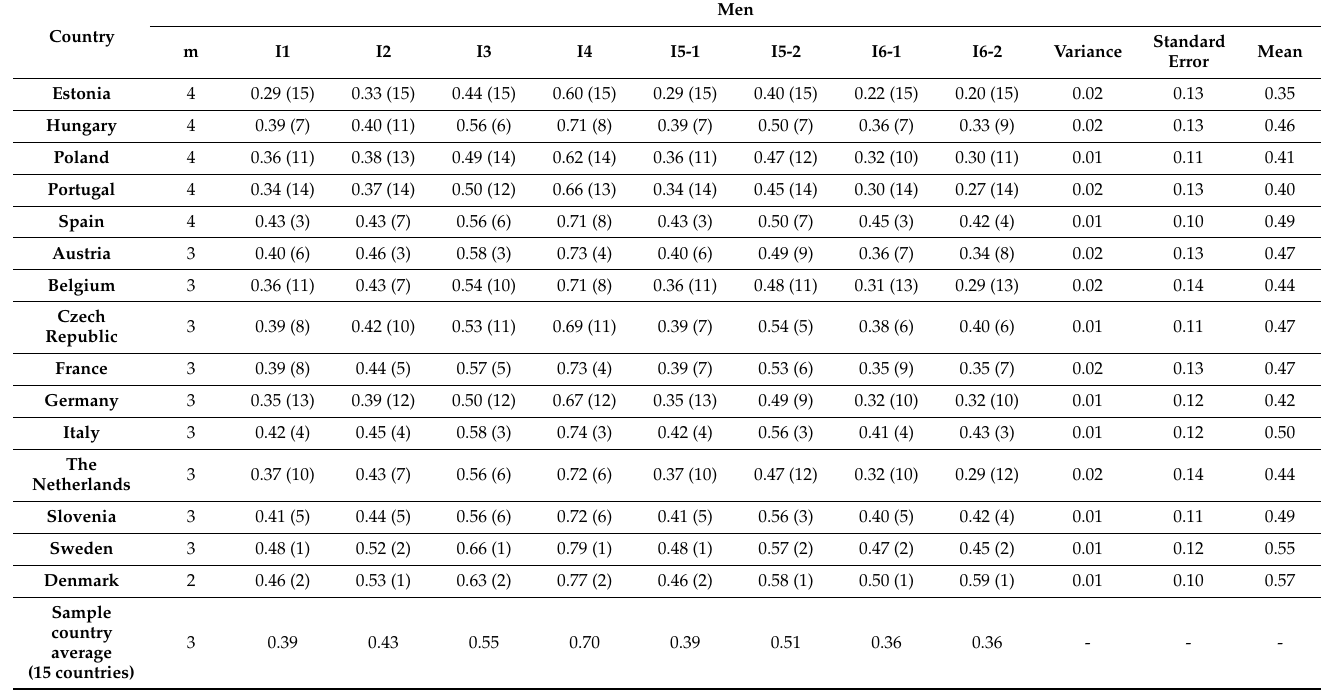
Table 7. Inequality indicators in self-perceived health in Wave 4 (2010) for men.